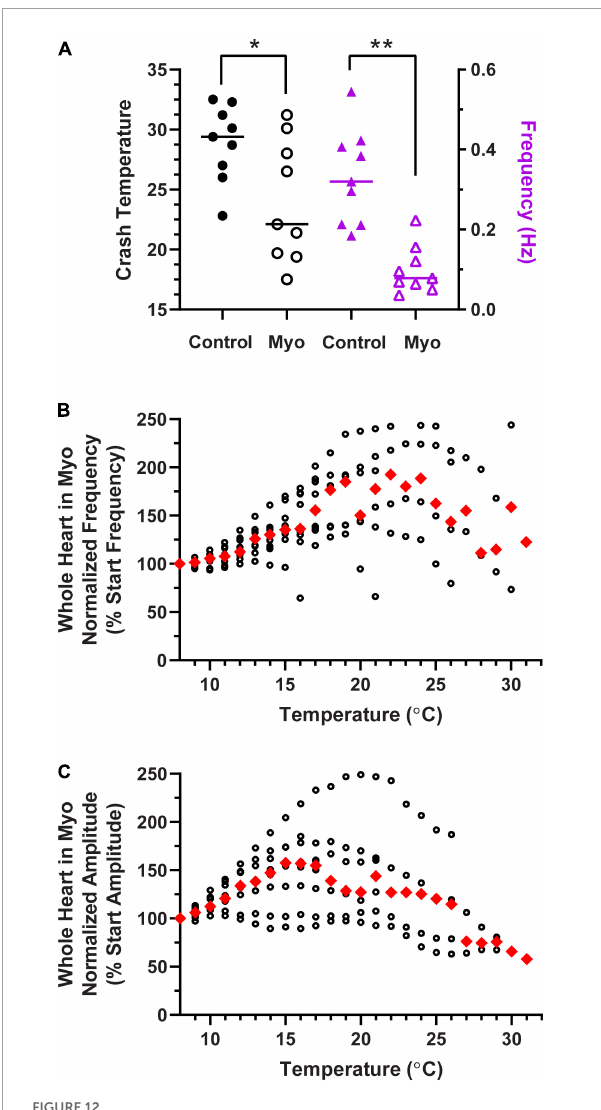
FIGURE12 Modulation of the cardiac neuromuscular system by myosuppressin decreases crash temperature. (A) Comparison of crash temperatures between preparations perfused with saline (29.4 ◦ C, median) vs. 10 – 7 M myosuppressin (Myo; 22.1 ◦ C, median) in the same hearts. Myosuppressin decreased the temperature